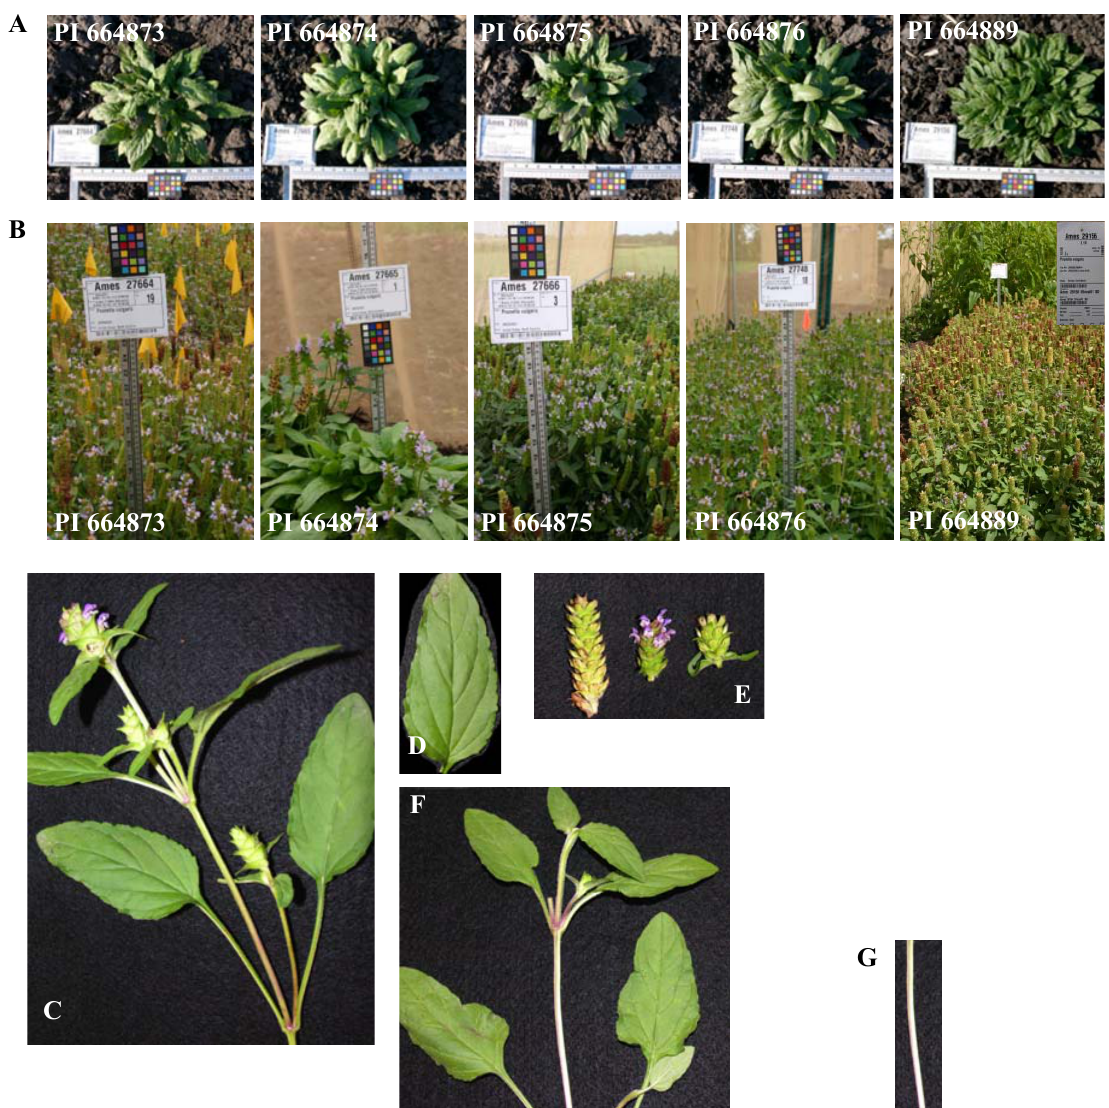
Figure 7. Prunella vulgaris accessions growing at the Plant Introduction Station, Ames,